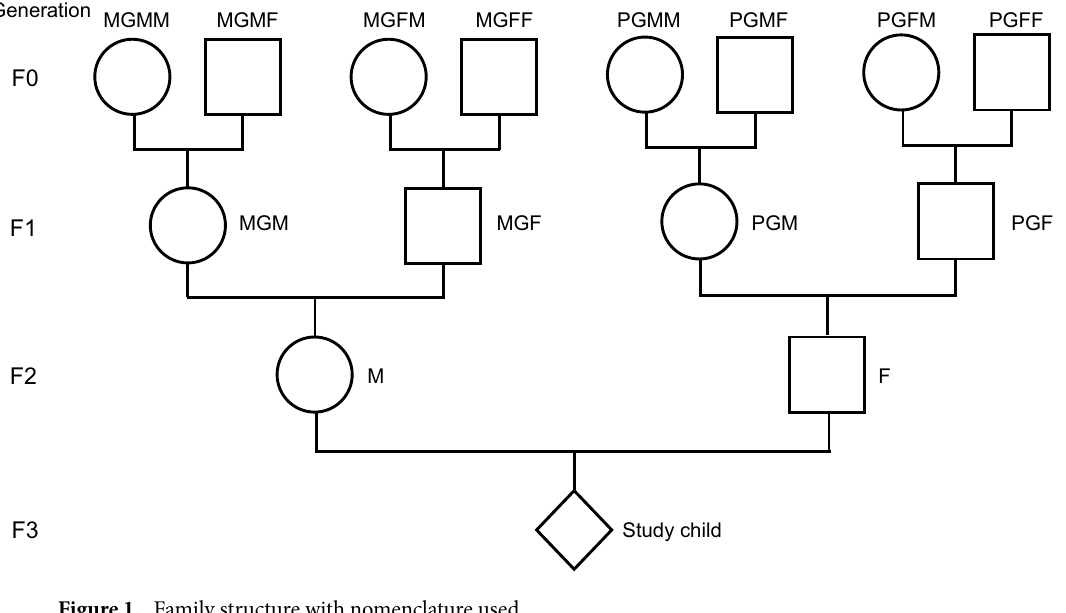
Figure 1. Family structure with nomenclature